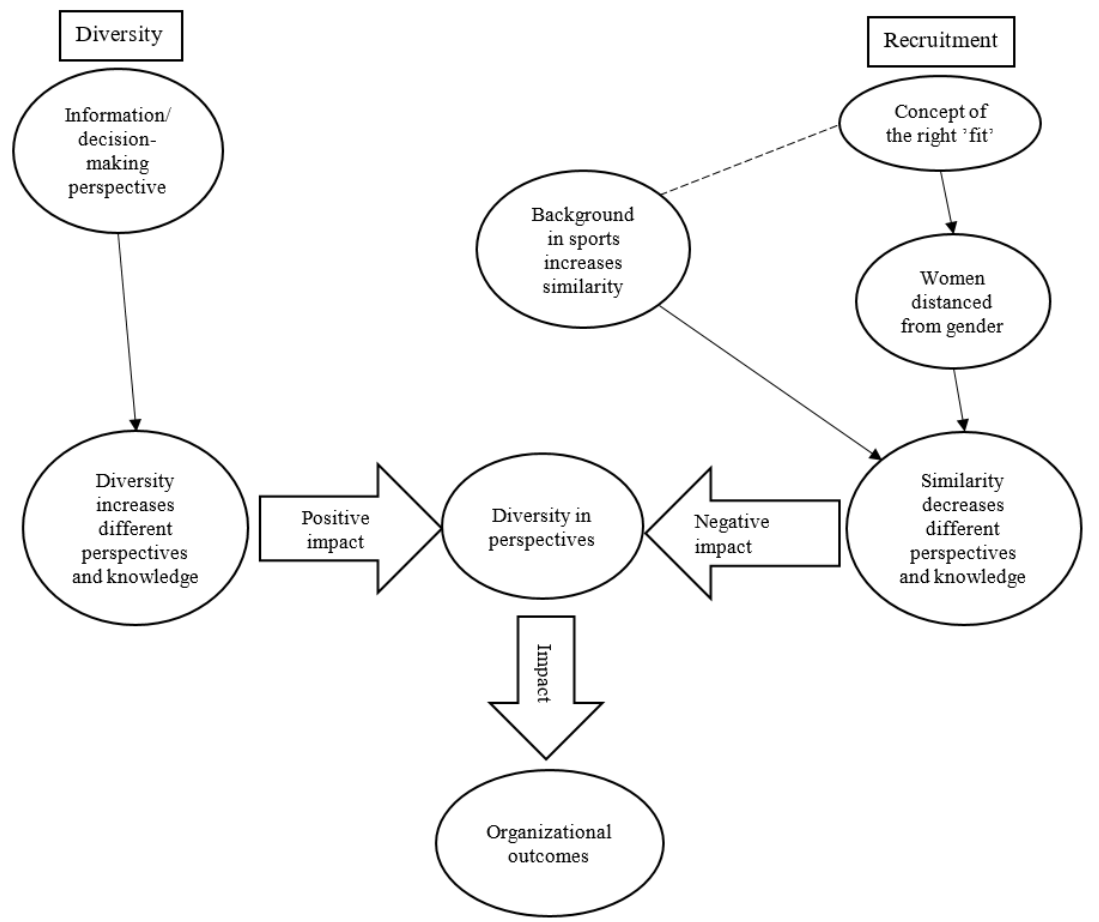
Figure 1. Theoretical model of the contradiction of diversity and gender-biased recruitment/selection processes of sport organization boards.